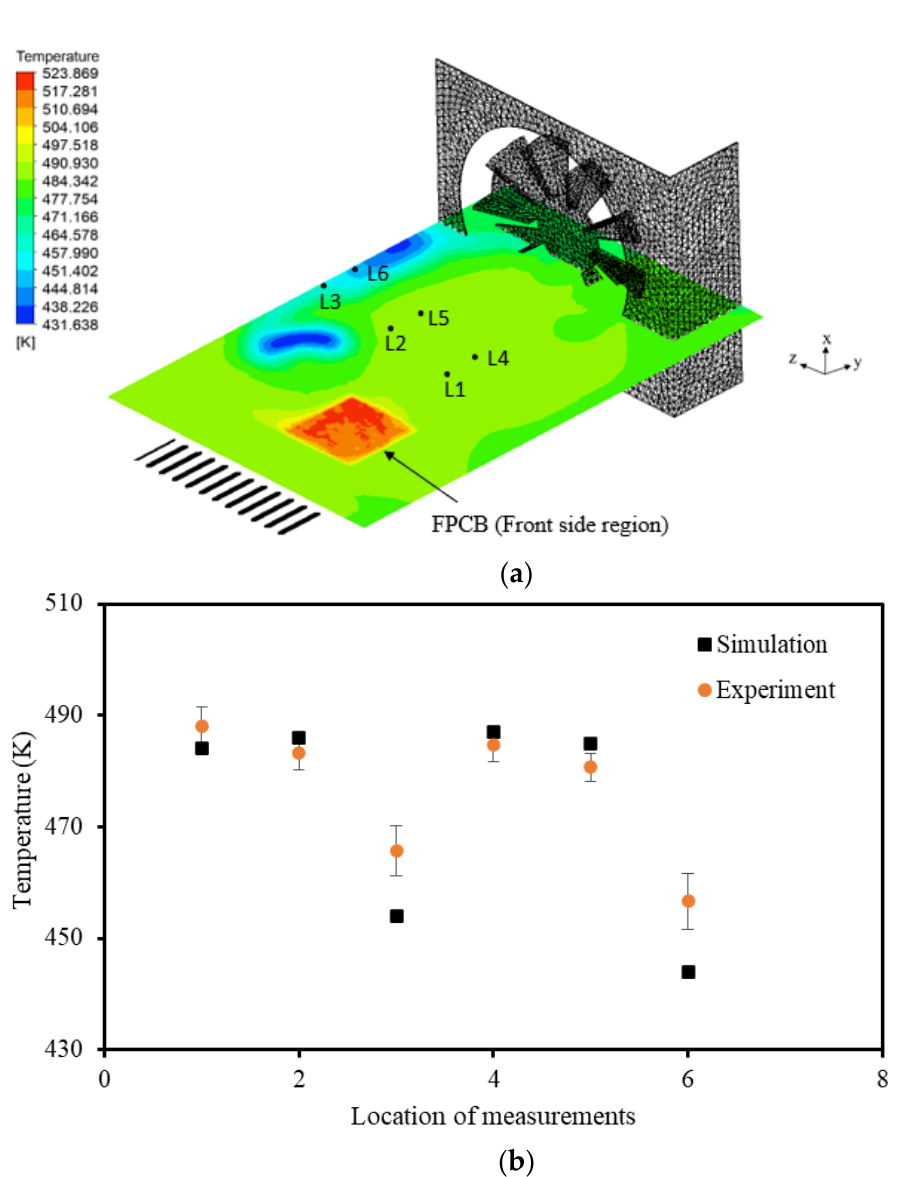
Figure 9. Comparison of simulation and experiment approaches during the reflow phase: ( a ) tem- perature distribution based on the simulation model, ( b ) validation of temperature measurement at L1~L6 at the z-axis.